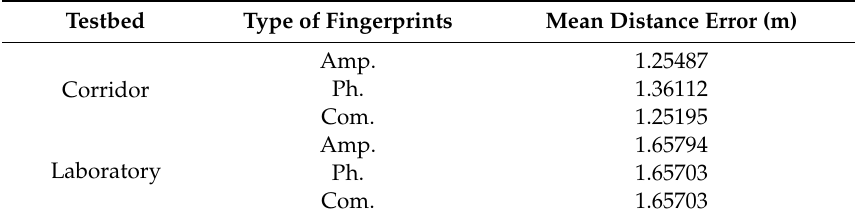
Table 6. Mean distance error without